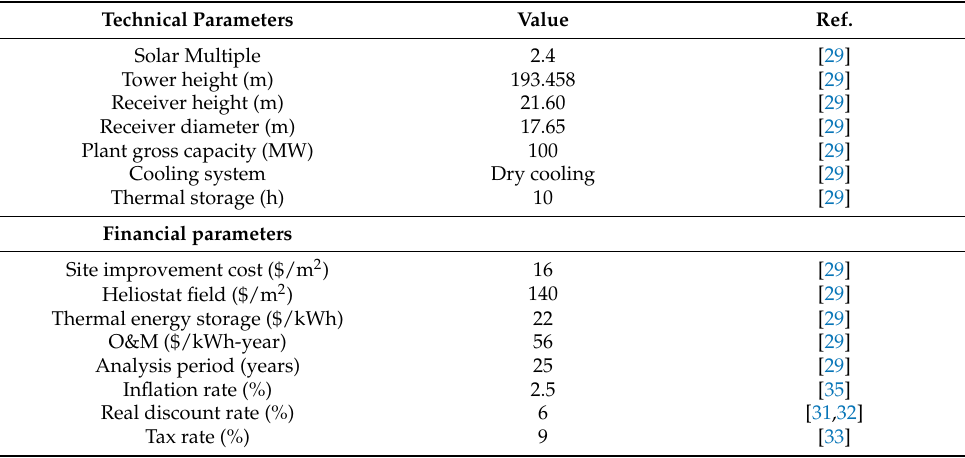
Table 1. CSP’s technical and financial parameters.